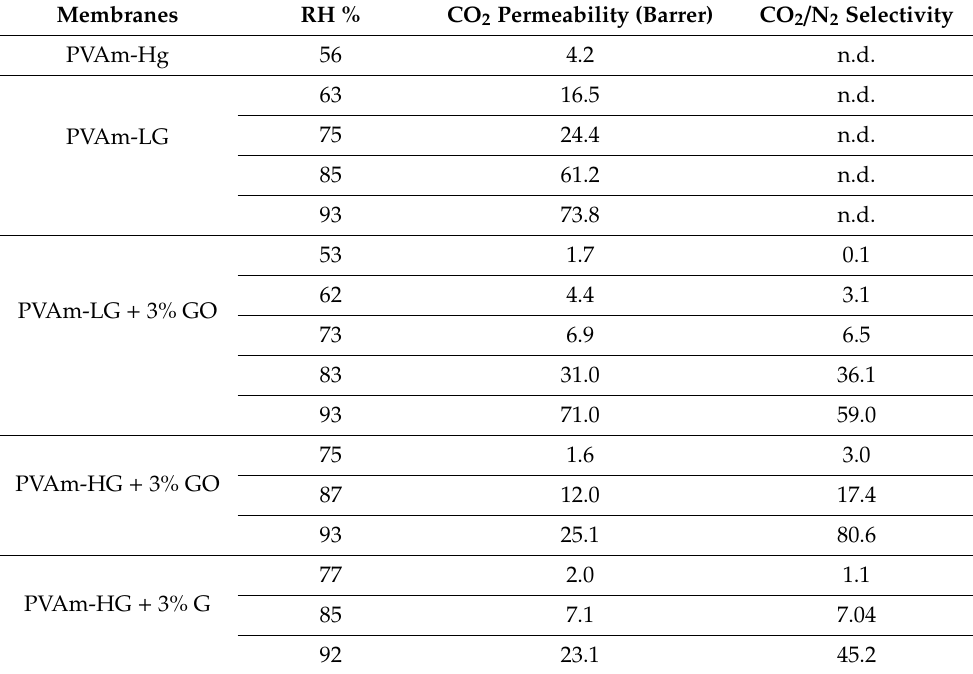
Table 2. Permeselective properties of the different membranes PVAm membranes.